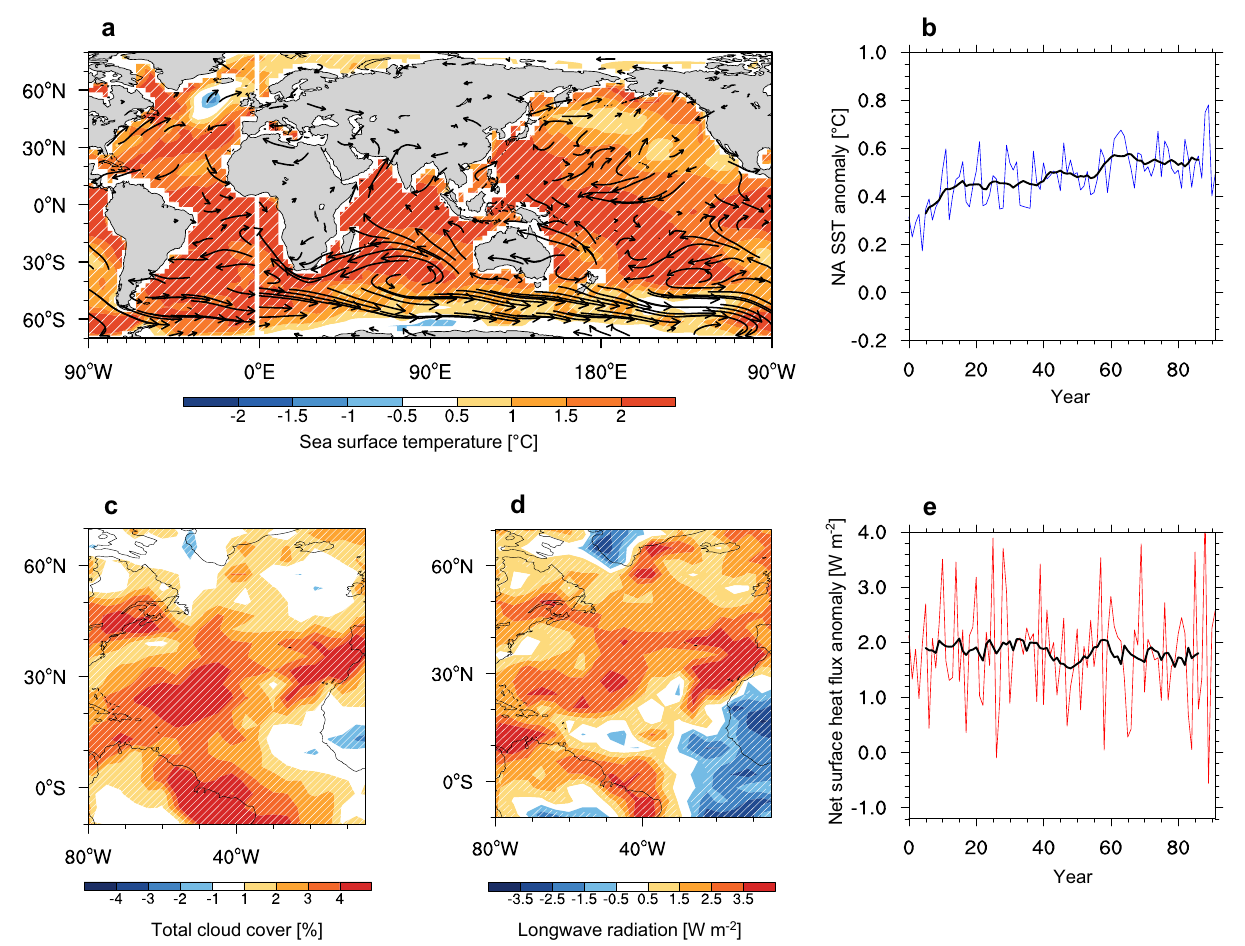
Fig. 2 Response of North Atlantic Ocean by Indian ocean warming from preindustrial simulations. a Anomalies in sea surface temperature (SST; unit: °C) and surface wind (vector in units of 0.6 mm per day) from the fi xed preindustrial (PI) simulation with observed IO SST anomalies. The anomalies are computed for the 100 years of the PI_IO + 1 C experiment with respect to the pre-industrial simulation (PI_IO + 0, see Methods). The hatched area represents the regressed SSTA and is signi fi cant at the 95% con fi dence, level. b Temporal evolution of SST anomalies averaged over the NA region. c Anomalies in total cloudiness (%). d Anomalies in longwave radiation (W m − 2 ). The downward direction is positive (warming). e Temporal evolution of net surface fl uxes (W m − 2 ). The red (or blue) line shows annual mean data and the black line shows an 11- year running mean of the red (or blue) line. 100- year simulated data are used for